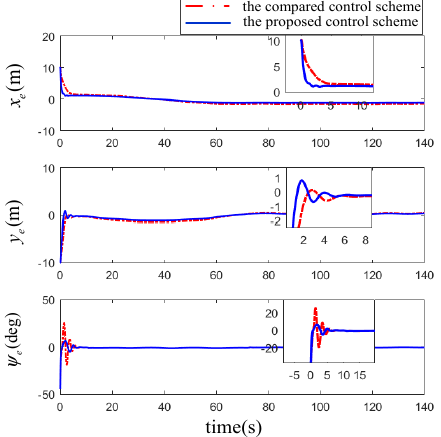
Figure 11. The error x e , y e , ψ e of comparison experiment: the proposed scheme (solid line) and the result in [28] (dot dash line).